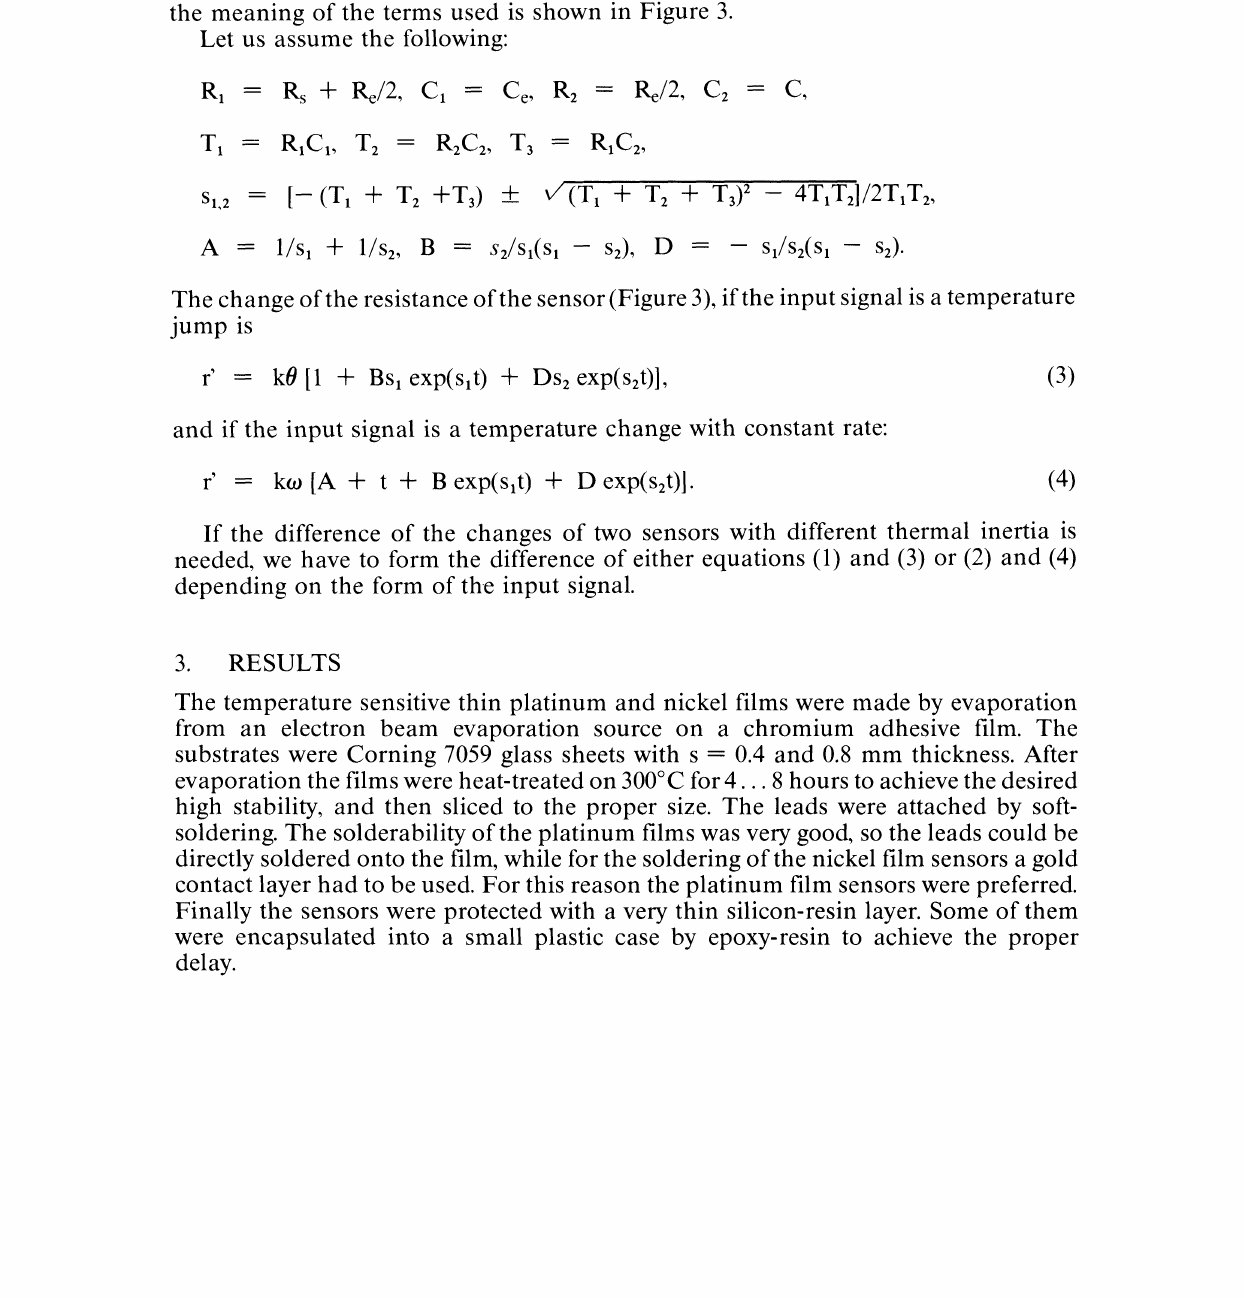
Af The model of a delayed